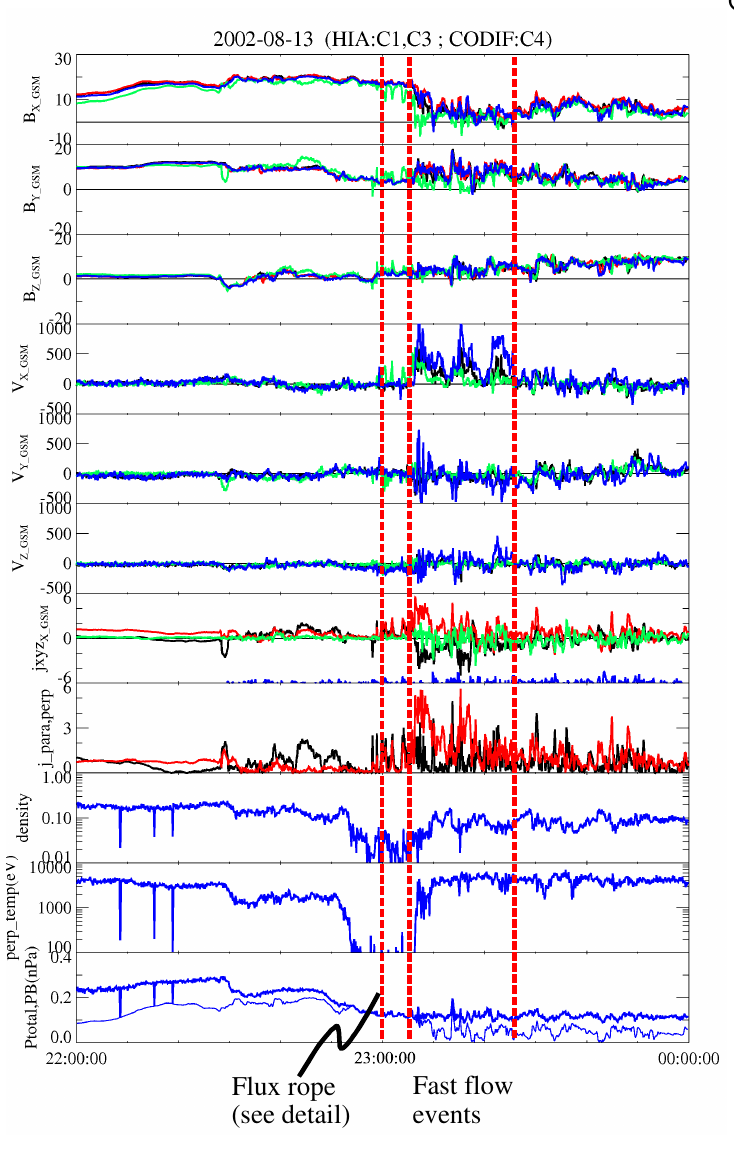
Fast flow Flux rope events (see detail) Fig. 3. (a) Cluster FGM and CIS data of 13 August 2002, from 22:00–00:00 UT, for the larger temporal environment of the event discussed. The CODIF instrument has been used for the CIS data of Cluster 4, HIA for CIS data of Cluster 1 and 3; colours for the different Cluster spacecraft as in Fig. 1. Panels from top to bottom: First to third panel: Magnetic field components in nT, in GSM coordinates; Fourth to sixth panel: Ion bulk velocities in kms − 1 , in GSM coordinates; Seventh panel: Currents determined with the curlometer technique in nAm − 2 , in GSM coordinates: black: X component, red: Y component, green: Z component; magneta: div B (quality parameter, should ideally be zero; plotted with an offset of –6nAm − 2 , for convenience); Eight panel: Currents parallel (black) and perpendicular (red) to the magnetic field, in nA m − 2 ; Ninth panel: Plasma density at the four different spacecraft, in ccm − 1 ; Tenth panel: Temperature perpendicular to the magnetic field, in eV; Eleventh panel: Total (thick line) and magnetic (thin line) pressure in nPa; the first vertical dashed line marks the flux rope event discussed in more detail in this study, the second and third dashed lines bracket three fast flow events. (b) Similar to (a), but detailed plot for the interval 22:57–23:03 UT, and using 22-Hz magnetic field data; the flux rope event is bracketed by the two vertical dashed lines. (c) Closeup on FGM 22-Hz magnetic field data for a 1-min interval around the flux rope event, in GSM coordinates. (d) Ion velocity distribution functions in three different planes from the CIS/HIA instruments on Cluster 3 at 22:58:51 UT, in GSE coordinates. The logarithmic colour scale represents counts per